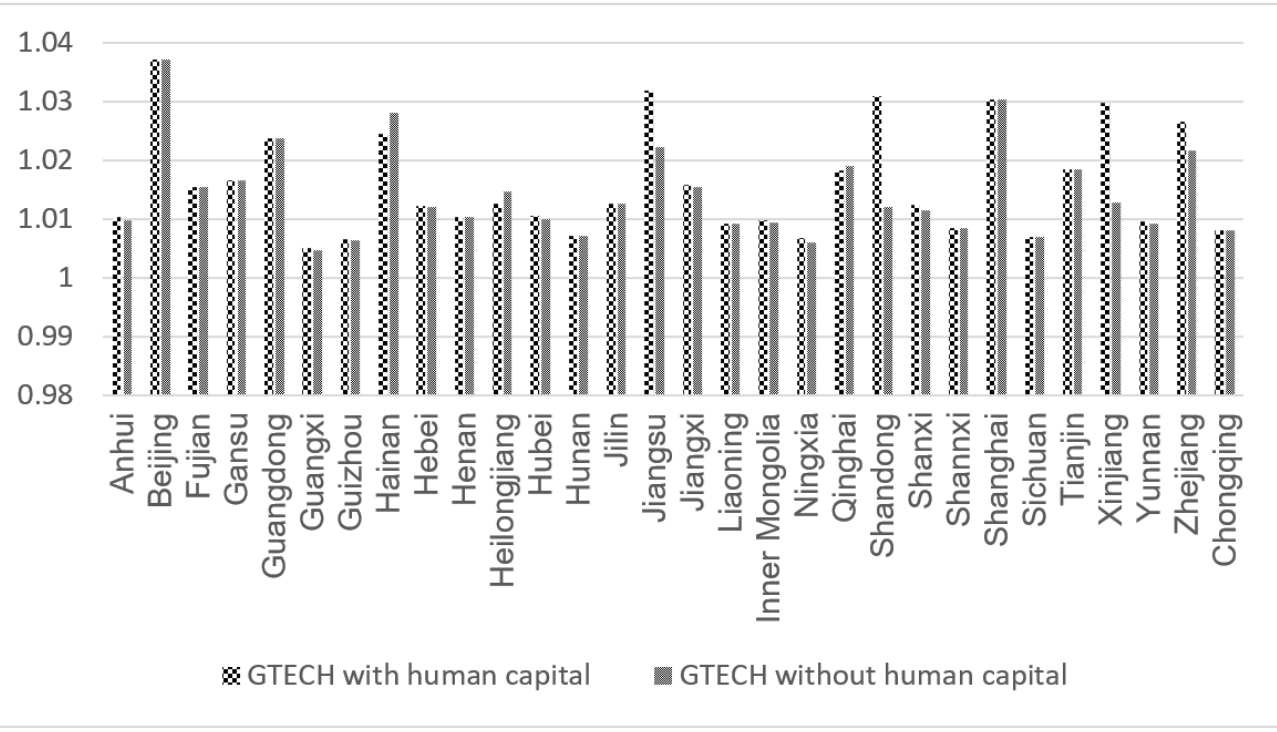
Figure 7. Comparison of technological progress among regions.